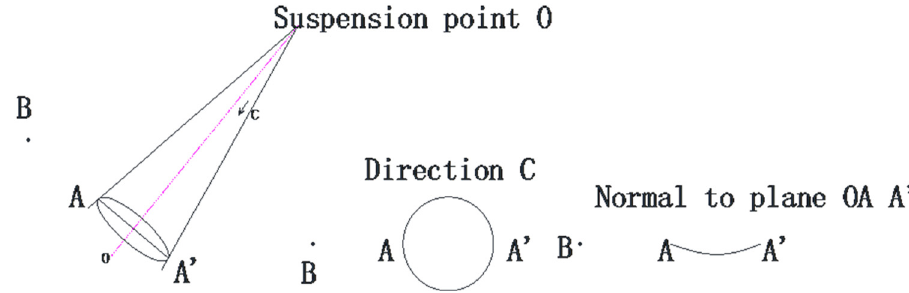
Figure 2: Arbitrary point on the surface of the moving